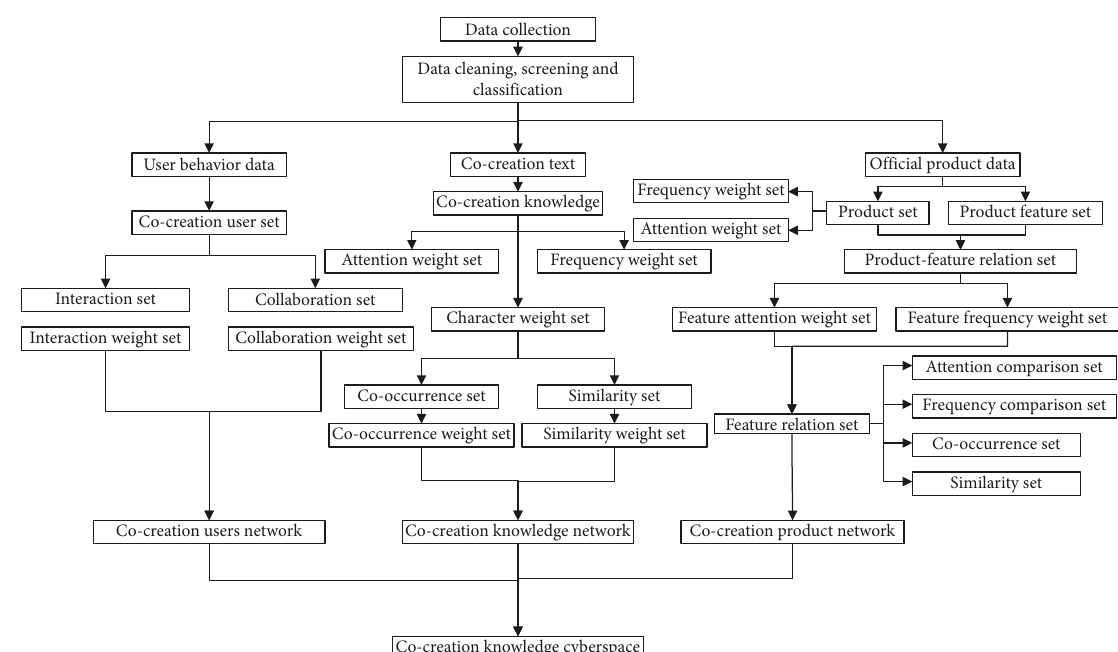
Figure 12: Case study application analysis flow